Question: Write a single sentence explaining what this figure depicts.
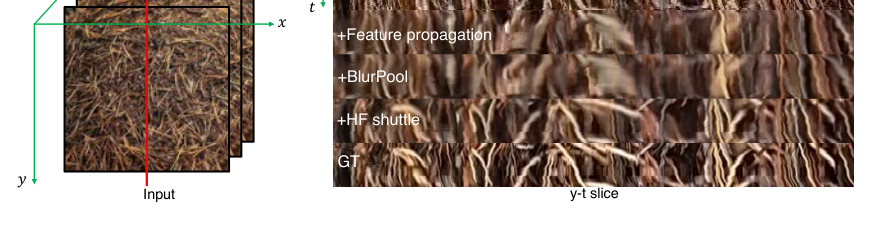
Answer: Ablation study. Starting from the inflated GigaGAN (+Temporal attention in the figure), we progressively add components to demonstrate its effectiveness. With temporal attention, the local temporal consistency is improved compared to using image GigaGAN to upsample each frame independently. The global temporal consistency improves with feature propagation, but aliasing still exists in the areas with high-frequency details (please refer to the videos in the project website). Also, the video results become more blurry. By using the anti-aliasing blocks – BlurPool, the aliasing issue is much better, but the video results become even more blurry. Finally, with HF shuttle, we can bring the per-frame quality and high-frequency details back while preserving good temporal consistency.